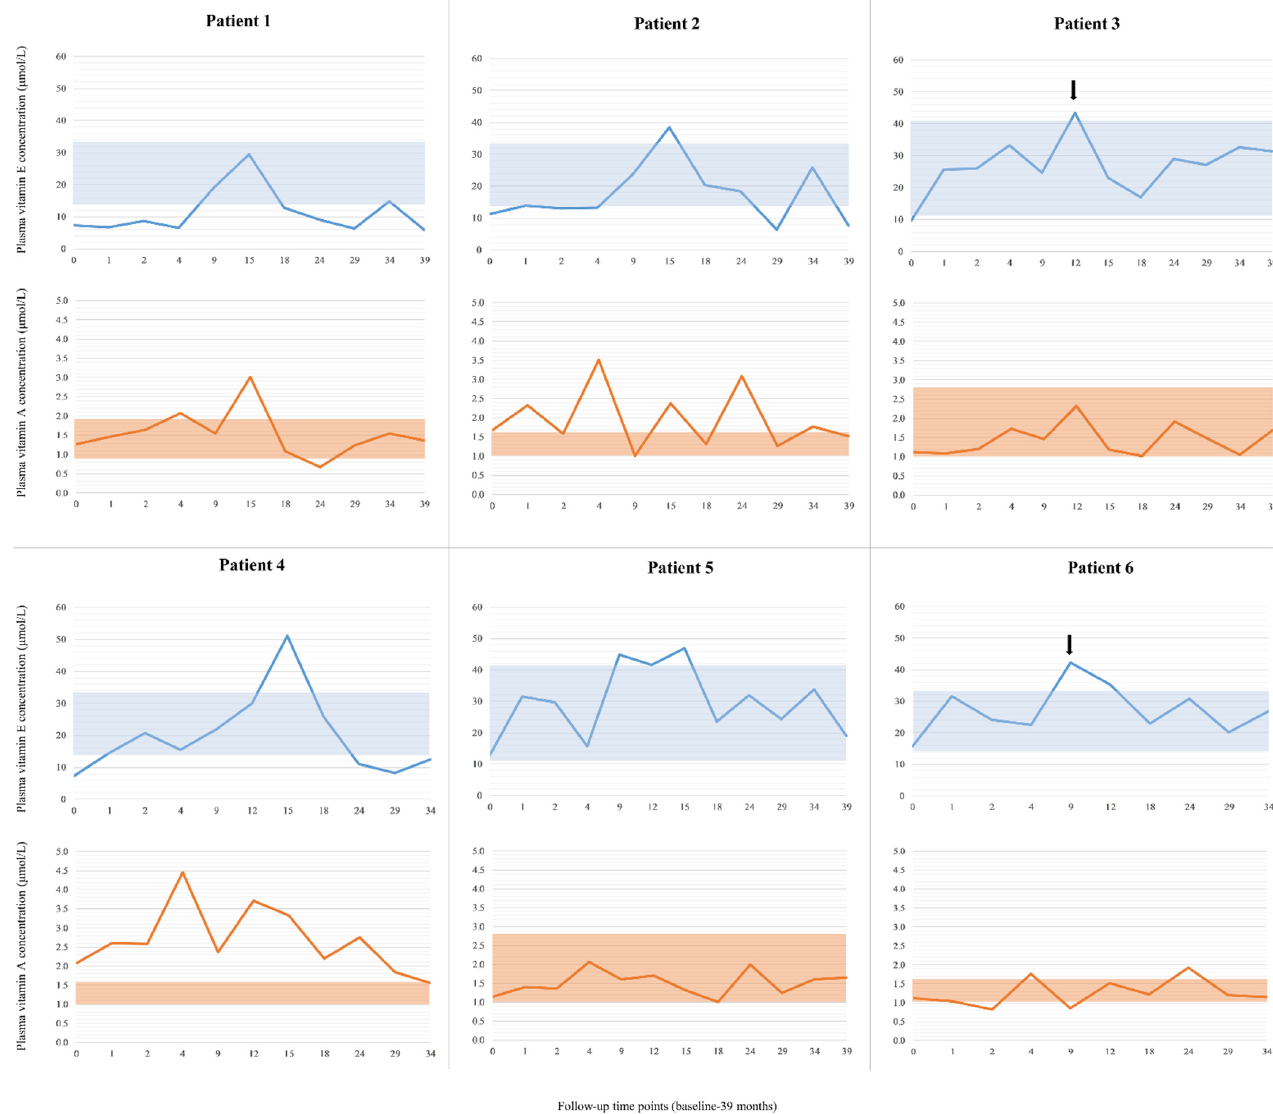
Figure 2. Plasma vitamin E and A concentrations in SLOS patients before and during supplementation with vitamin E. Age-matched reference intervals for plasma vitamin E and A concentration are shown by the blue and orange boxes, respectively. Starting doses of vitamin E were decreased by 50% in the case of Patients 3 and 6 (arrow). Time point “0” represents the baseline